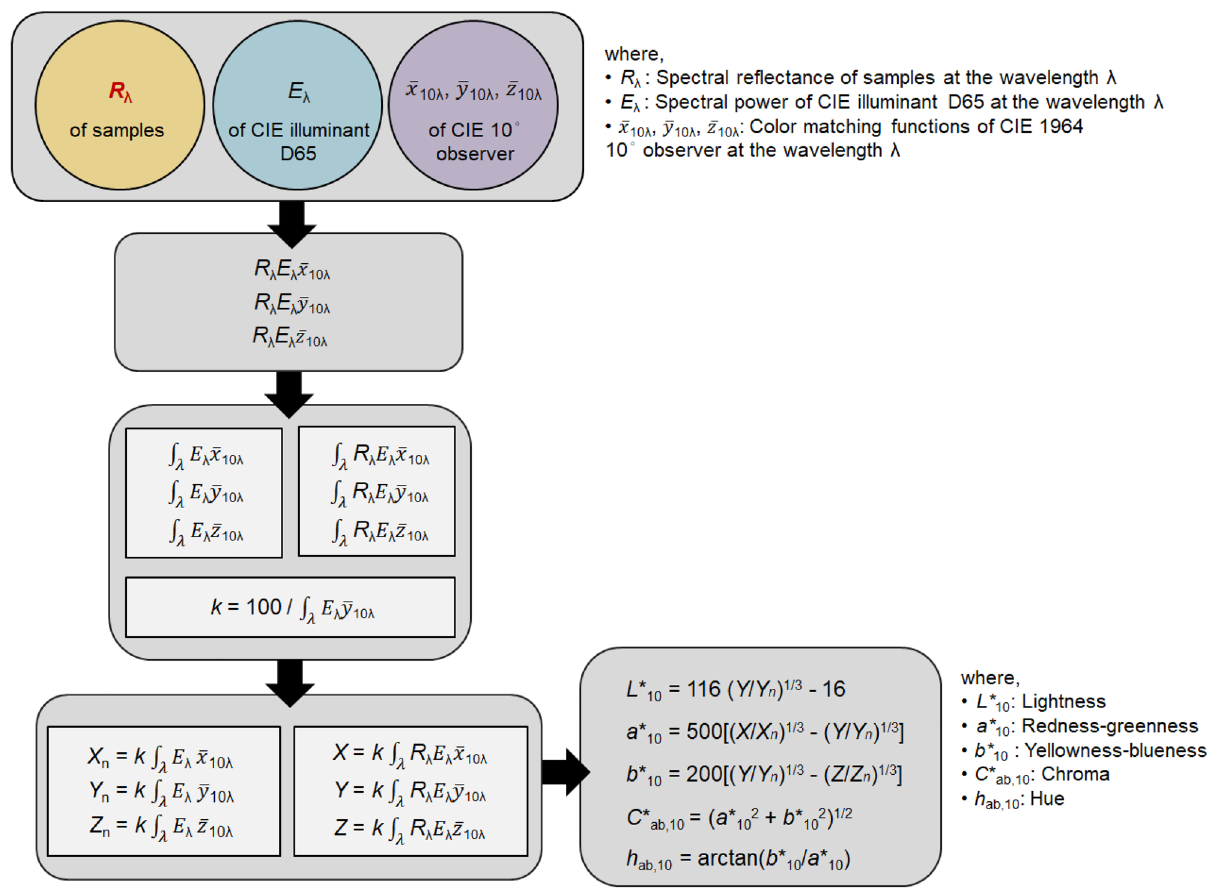
Figure 5. Procedure for calculating L * 10 , a * 10 , b * 10 , C * ab,10 , and h ab,10 values from R values.